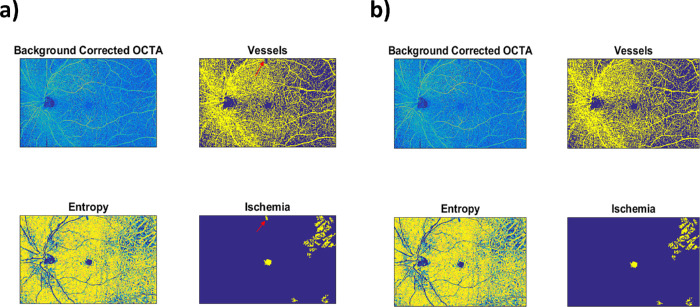
(A) In step two, a little shadowing artifact visible at the superior vascular arcade was considered erroneously as nonperfusion area by the algorithm (red arrow). (B) In step three, a manual correction was performed and ischemic areas were recalculated again with the automated algorithm.